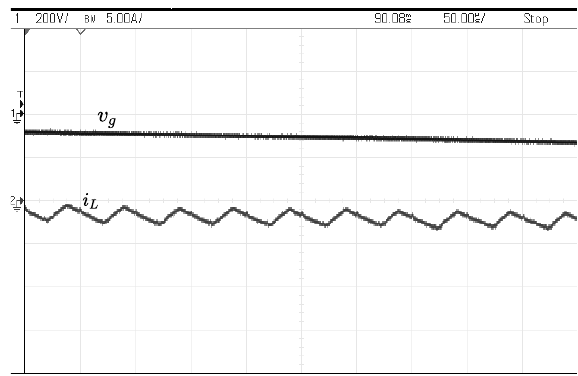
Figure 24. Zoomed view of inductor current.